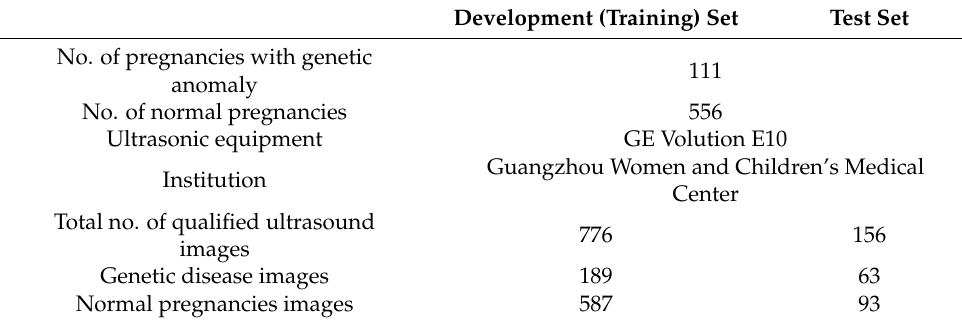
Table 1. Characteristics of the development set and the test